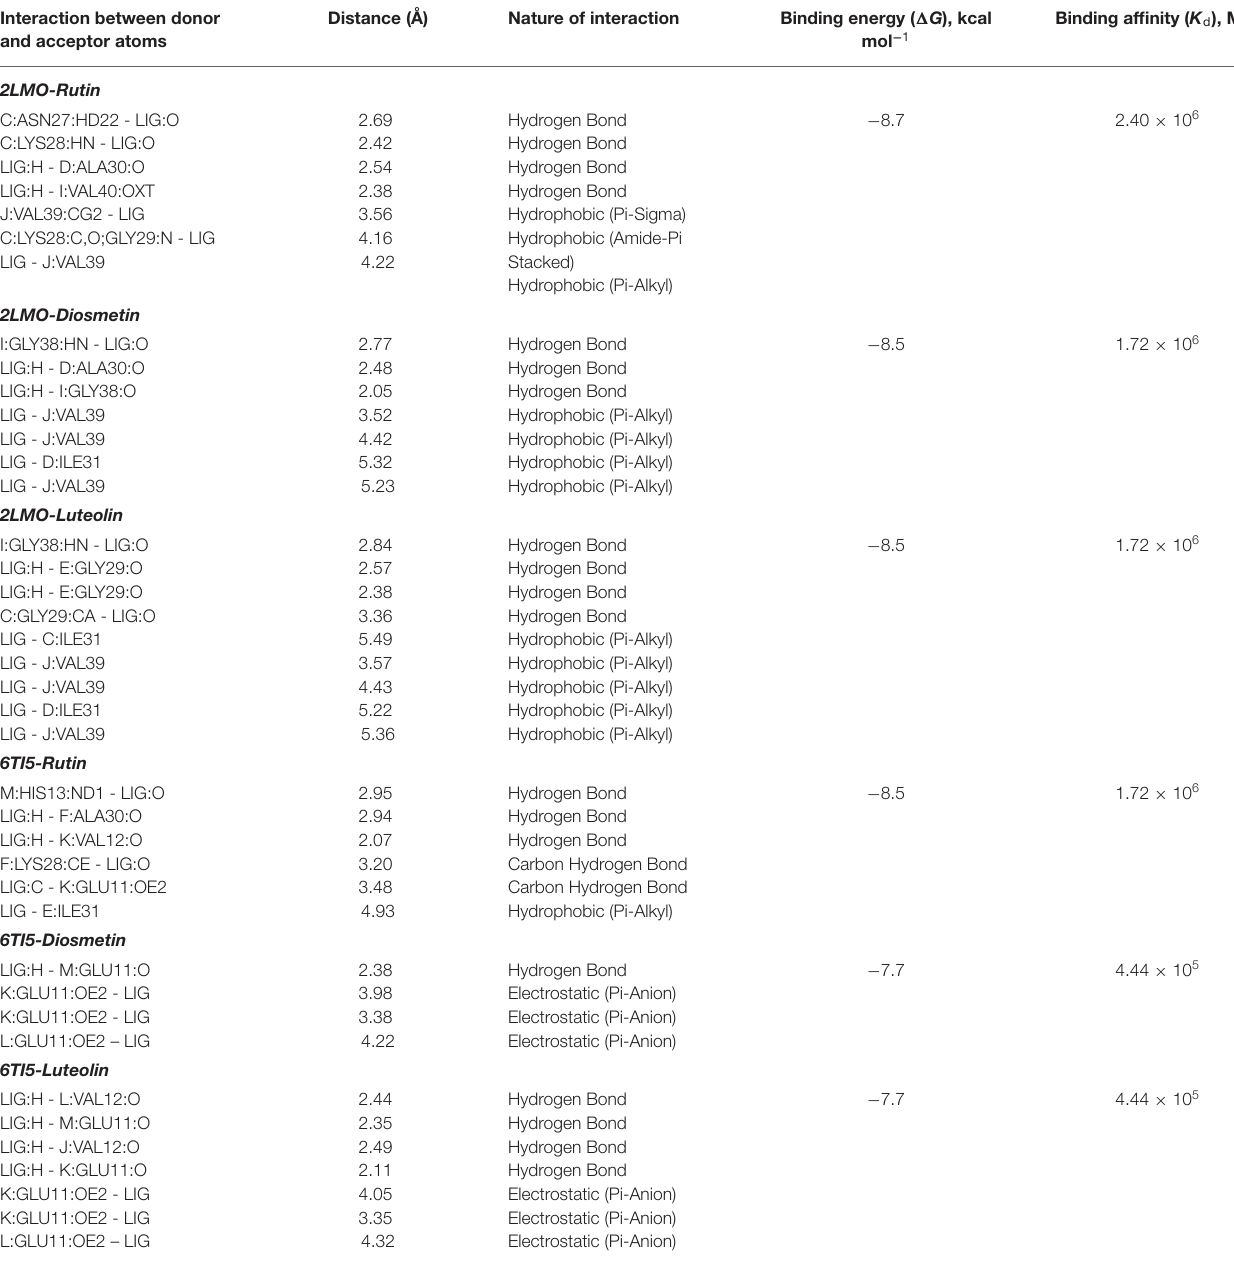
Distance (Å) Nature of interaction Binding energy ( 1 G ), kcal